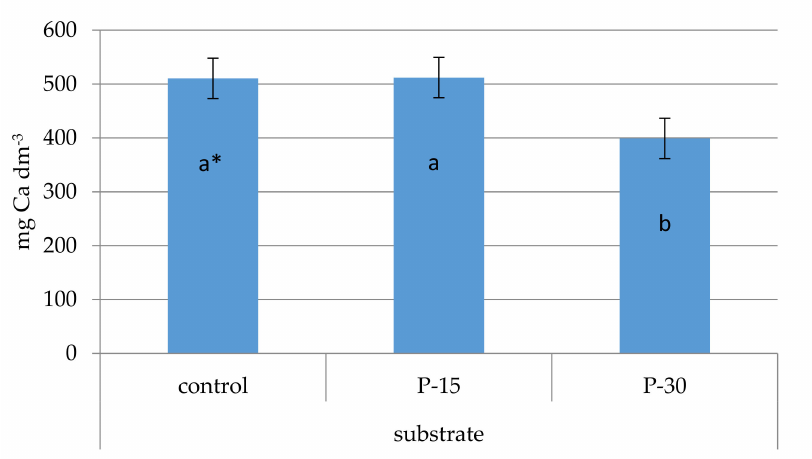
Figure 5. Calcium concentration in the substrate depending on the level of PP (polyphosphates) applied in the drip nutrient solution, on average for the growing period of pepper. * The bars marked with the same letters do not di ff er significantly according to the Tukey HSD test at α = 0.05.